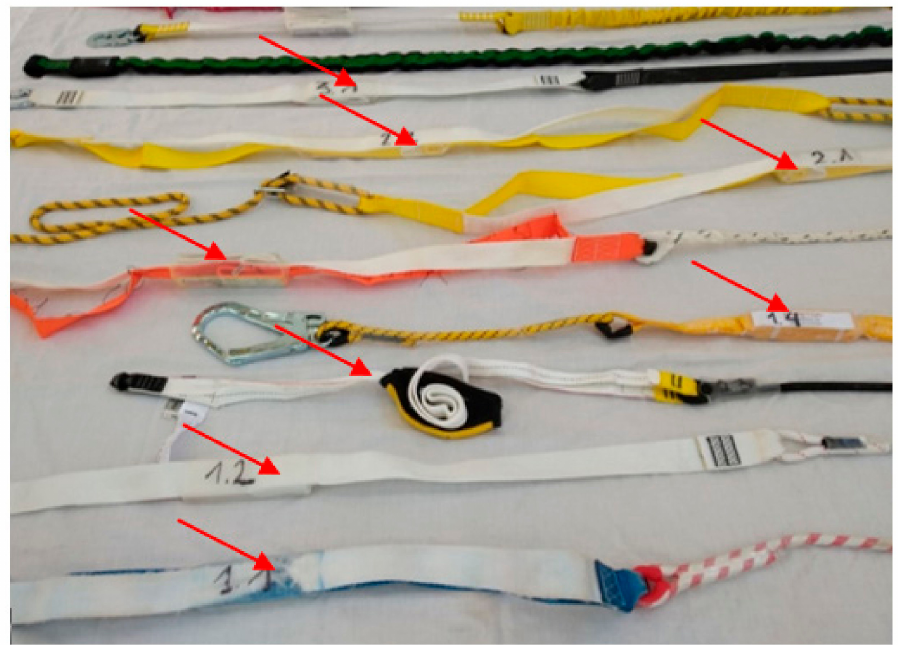
Figure 7. Samples after dynamic behavior